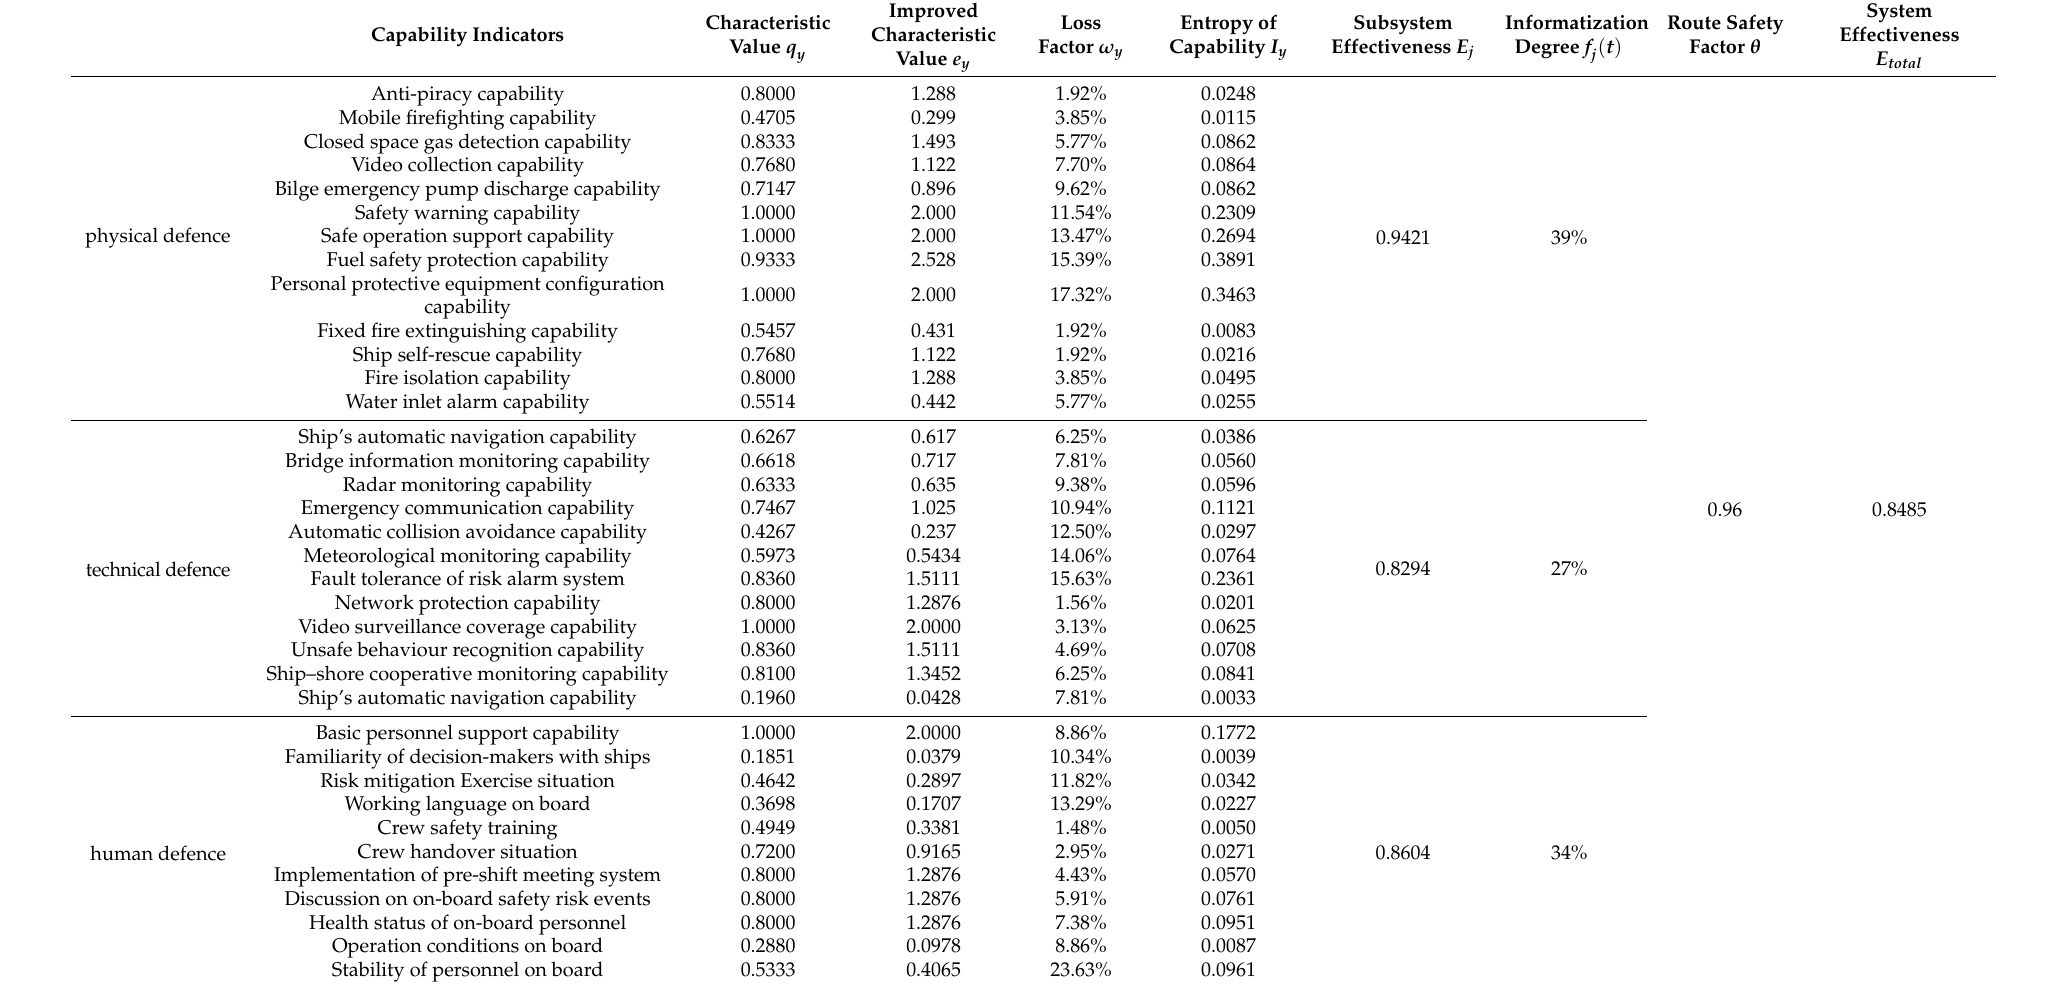
Table 9. Statistical analysis data for the 36 capability indicators under the three